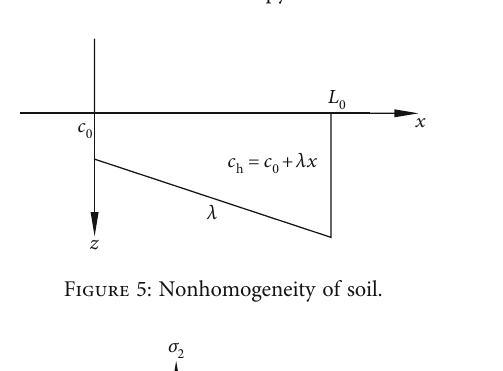
Figure 4: Anisotropy of soil.